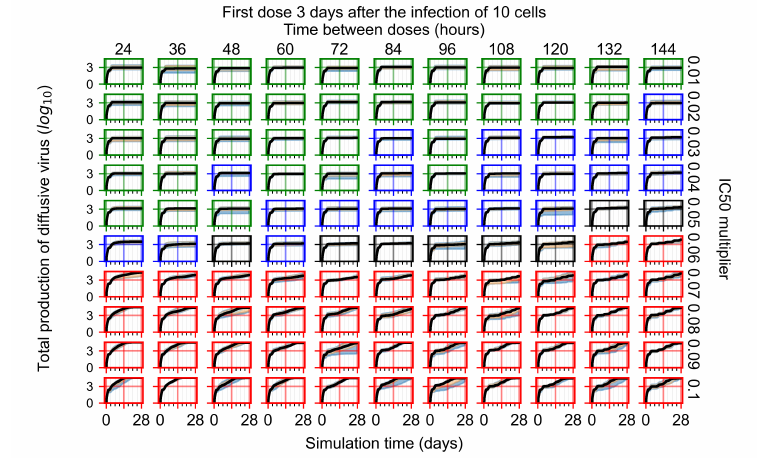
Figure A35. Total diffusive virus produced (AUC), Y axis in log scale, and exponent values as tick marks.